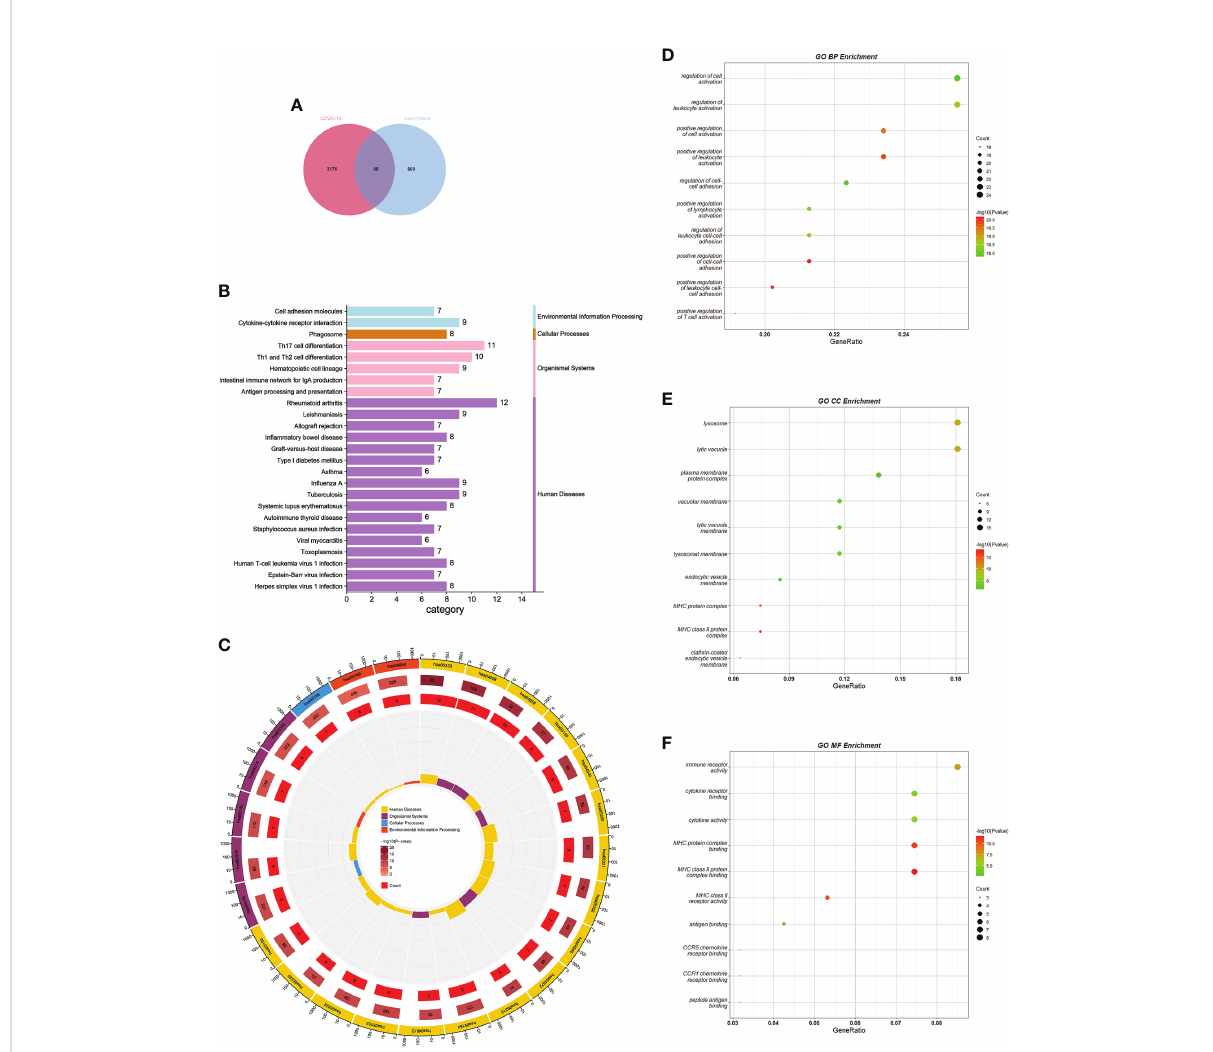
FIGURE 2 GO and KEGG pathway enrichment analysis of common DEGs. (A) Screening process of common DEGs. (B) KEGG enrichment analysis bar graph. Horizontal coordinates indicate the number of genes annotated to this pathway, and different colors indicate different pathway classi fi cations. (C) KEGG enrichment analysis circle diagram. The fi rst circle indicates the fi rst 25 pathways, and the number of genes corresponds to the outer circle. The second circle indicates the number of genes and P-values in the genomic background. The third circle indicates the number of genes annotated to this pathway. The fourth circle indicates the enrichment factor for each KEGG term. (D – F) GO enrichment analysis bubble chart. The size of the dots corresponds to the number of genes annotated to this term, and the color of the dots corresponds to the magnitude of the P-value. GO, gene ontology; DEGs, differentially expressed genes; KEGG, Kyoto encyclopedia of genes and